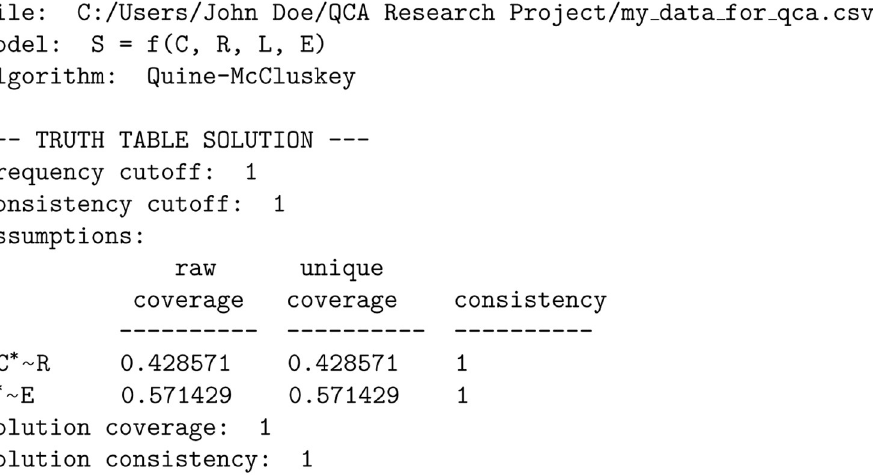
Fig 2. Output of fs/QCA software for an analysis of Doe’s